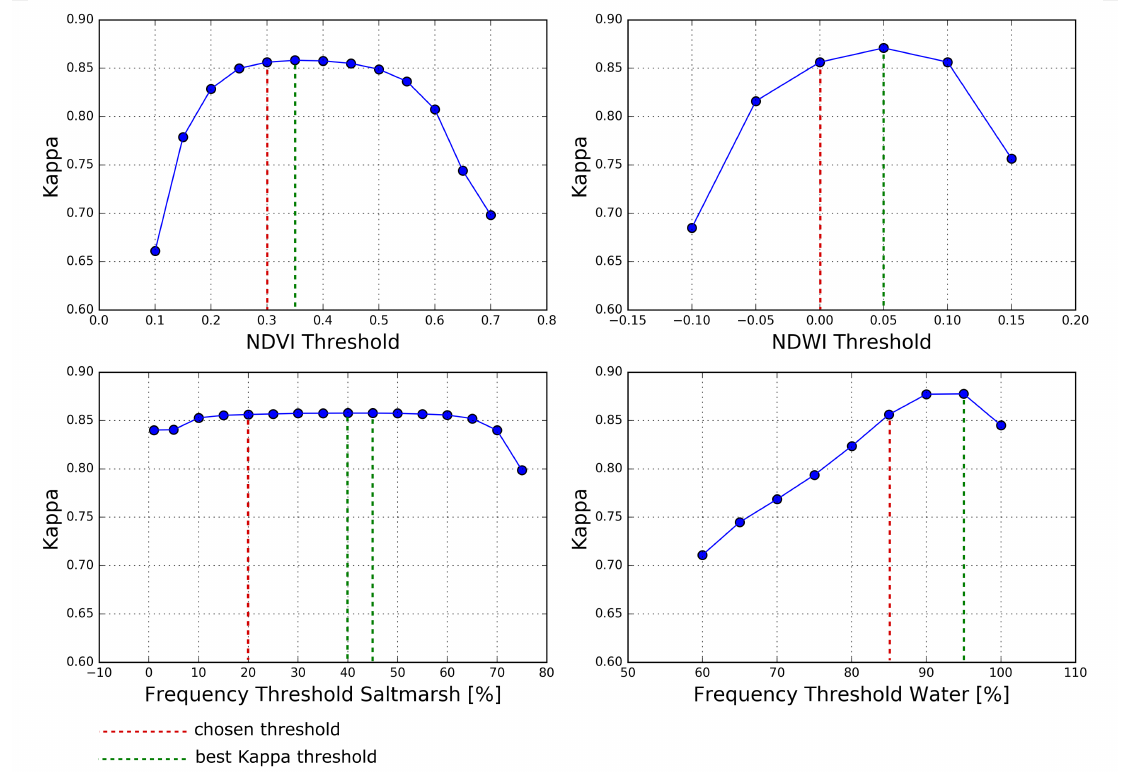
Figure 4. Sensitivity analysis of our unsupervised classification method to NDVI and NDWI thresholds and the frequency thresholds defining saltmarsh and water in the final classification. Kappa is computed for different thresholds based on the validation data set of the Western Scheldt 1995.